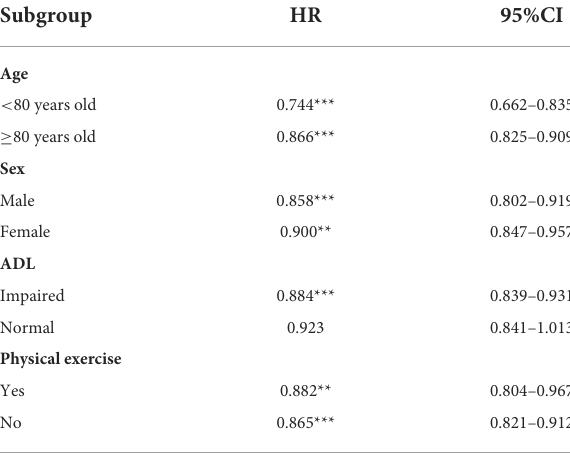
TABLE 3 Subgroup analyses of association between nut consumption and